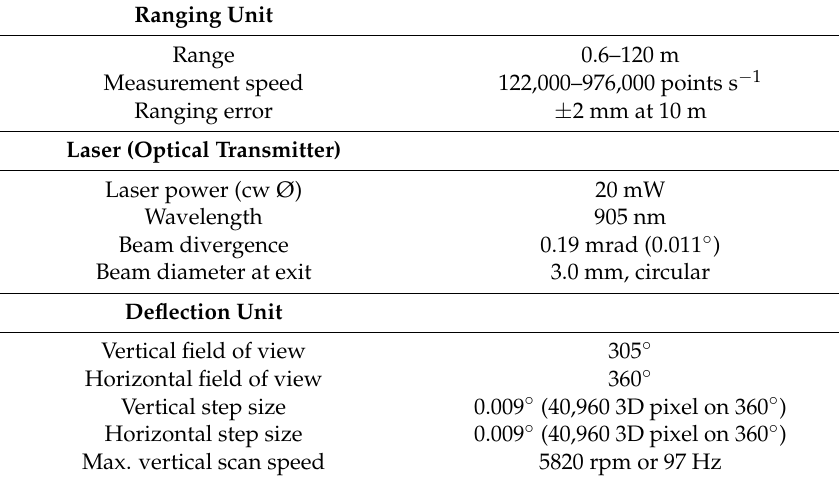
Table 2. Scanner